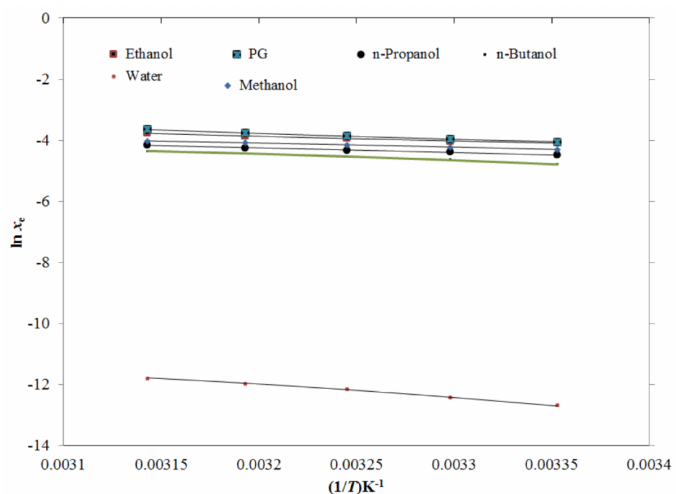
Figure 6. The correlation of ln x e values of TRV with the modified Apelblat model in six different mono-solvents as a function of 1/ T ; symbols represent the experimental solubilities of TRV, and solid lines represent the solubilities of TRV calculated using the modified Apelblat